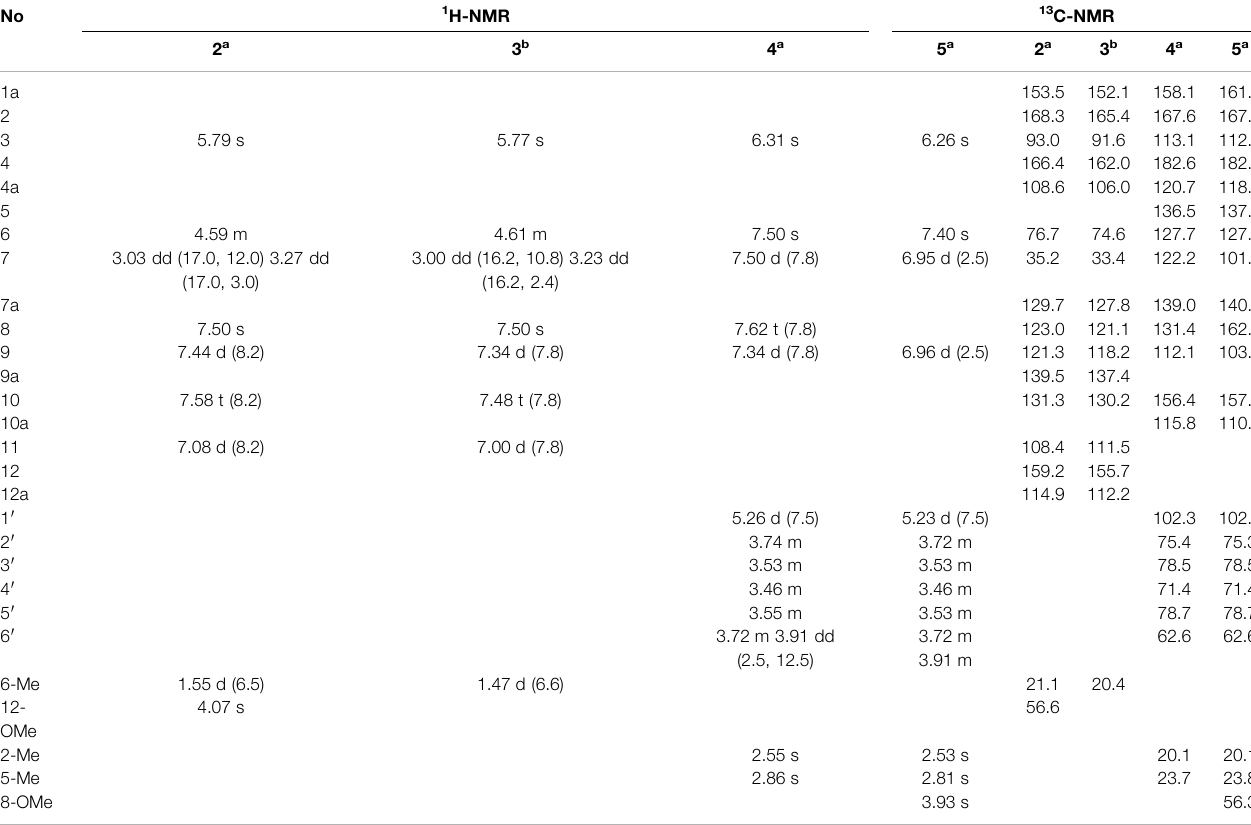
TABLE 1 | 1 H NMR and 13 C NMR data of compounds 2-5 ( δ in ppm, J in Hz).